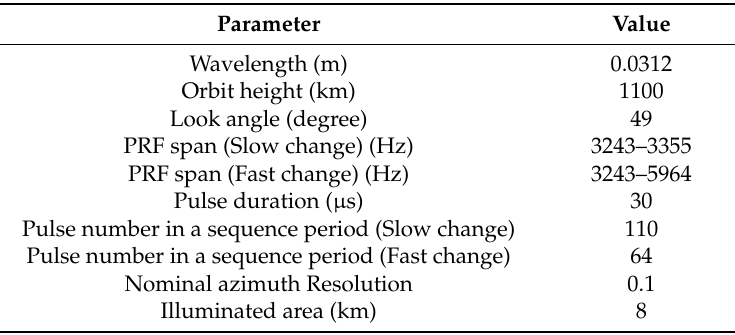
Table 1. SAR parameters of two types of PRI